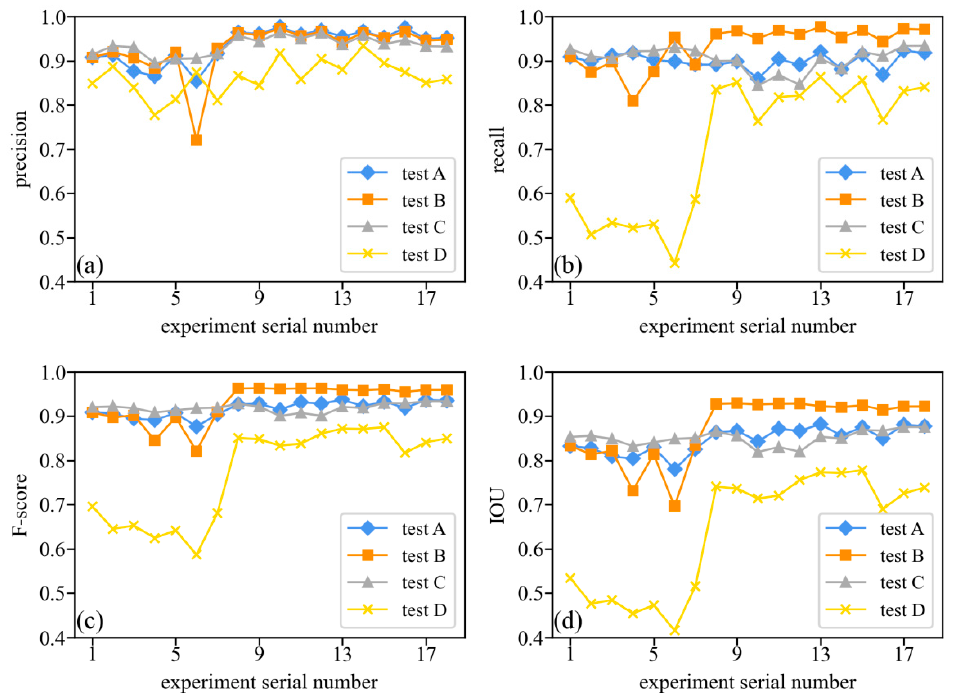
Figure 14. Evaluation index value of floating raft aquaculture of four test images. ( a ) Precision. ( b ) Recall. ( c ) F-score. ( d ) IOU.